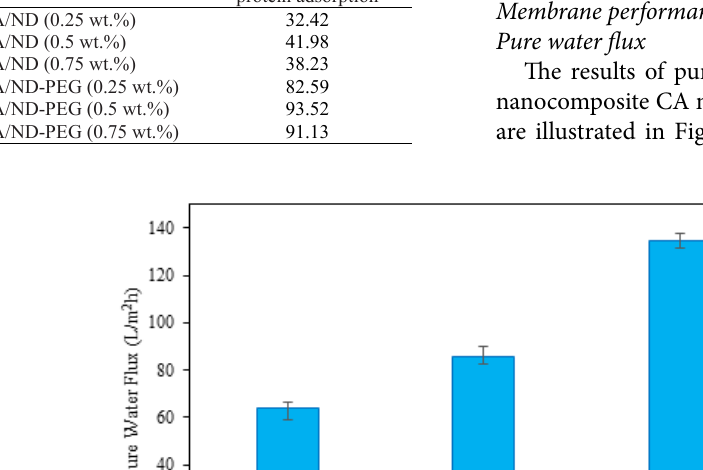
Table 3. Percent reduction of protein adsorption based on adsorbed proteins via pure CA membrane. Membrane